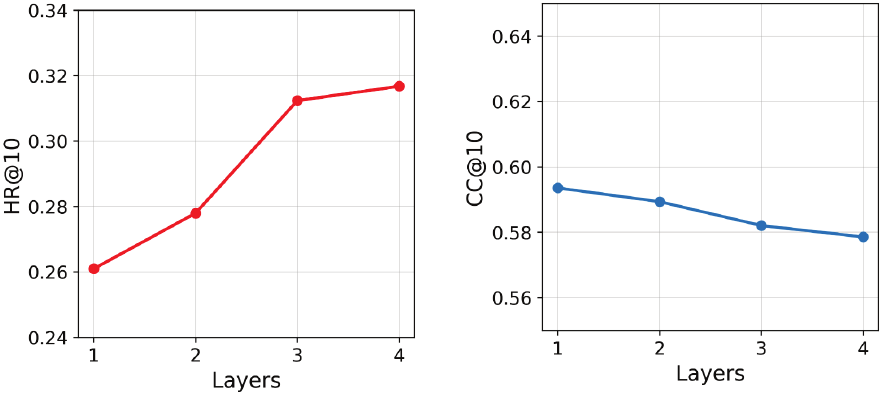
Figure 3. Results of different number layers on the Movielens 10M dataset in terms of HR@10 and